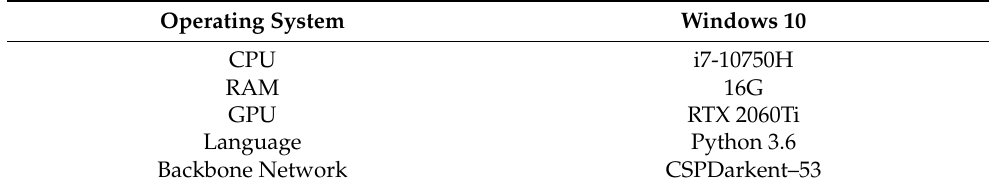
Table 1. Numbers of various types of images.